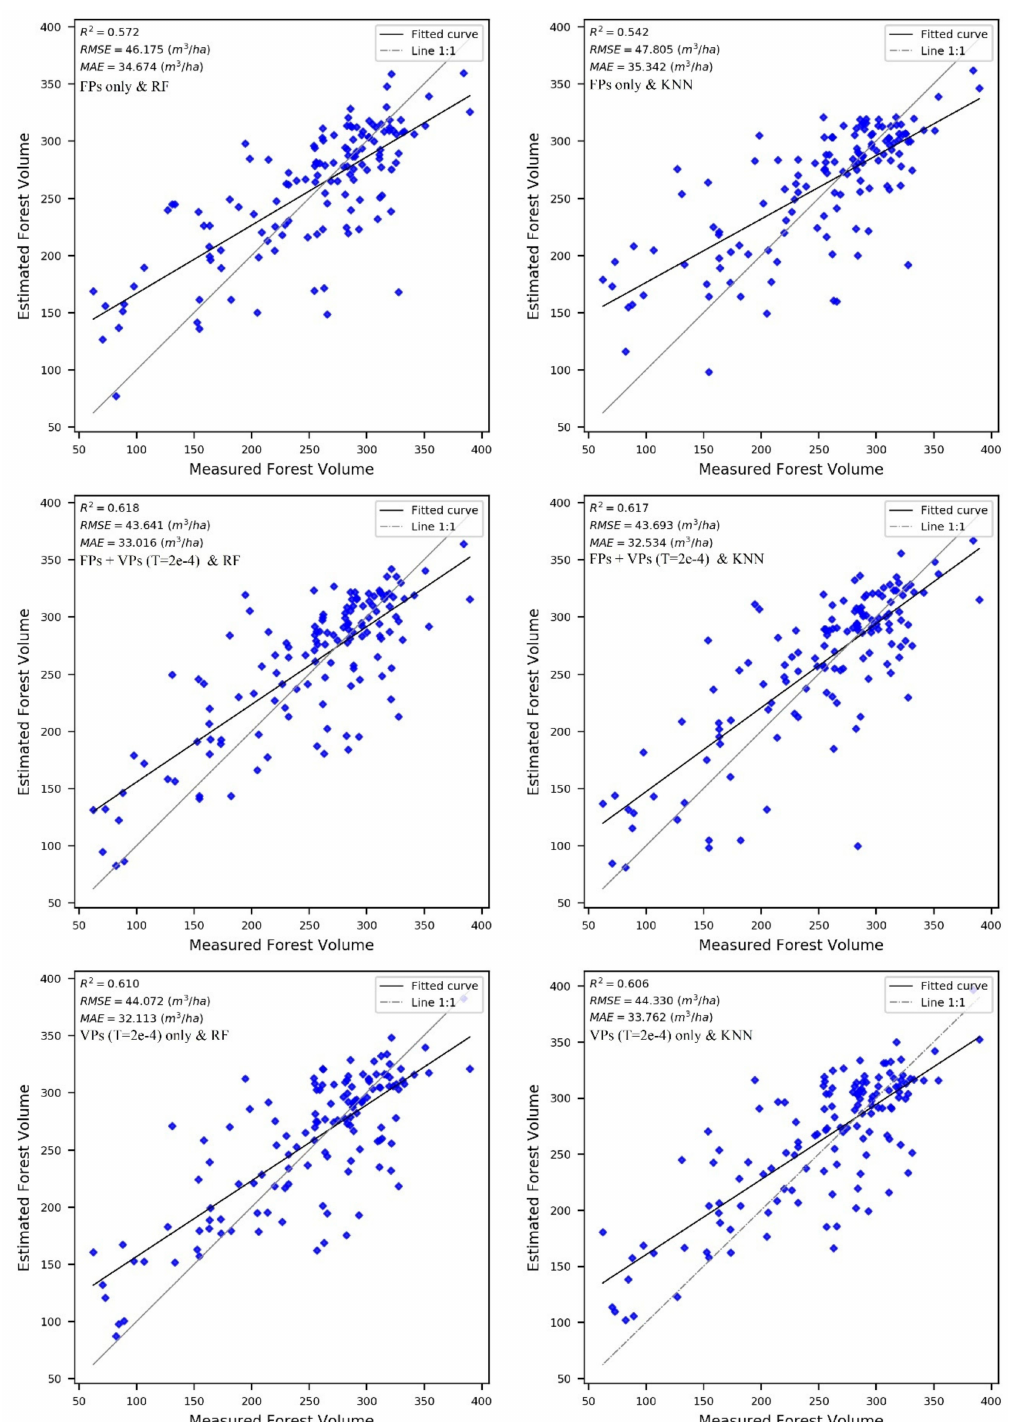
Figure 9. Accuracy validation for the estimated forest volume with optimal threshold value T = 2 × 10 − 4 and FPs